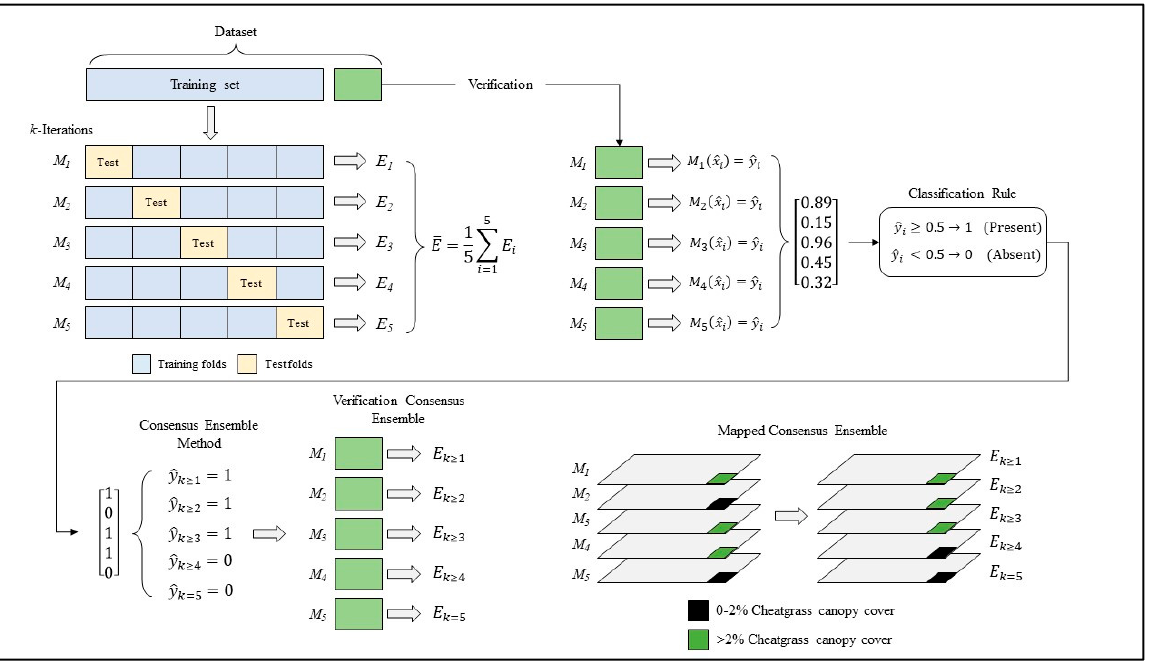
Figure 4. Process diagram illustrating how cross-validation and verification performance metrics ( E ) are assessed. Beginning in the upper right, the dataset is split into training and verification sets. During cross-validation, five iterations of a model ( M i ) are trained and tested on different folds of the training set and performance ( E i ) is averaged across folds ( E ). Conversely, verification performance is assessed by ensembling the predictions from each of the k -fold models ( M i ) using the consensus method, which yields k estimates performance ( E k ). This same process is applied to each map